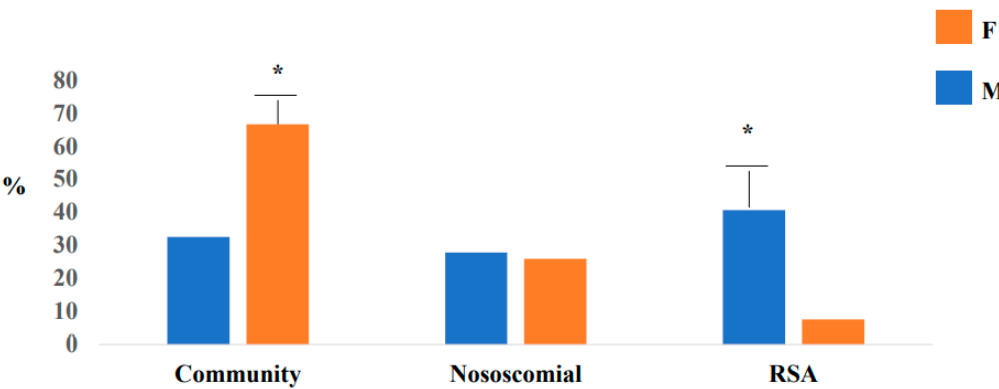
Figure 2. Epidemiological link by gender differences, * p < 0.001. RSA (Residence assistance for elderly). Table 2. Characteristics baseline in two groups (DM-HT and non-DM non -HT) of COVID-19 patients. SBP (systolic blood pressure); DBP (diastolic blood pressure); ICM (body mass index). DM-HT Group (n.